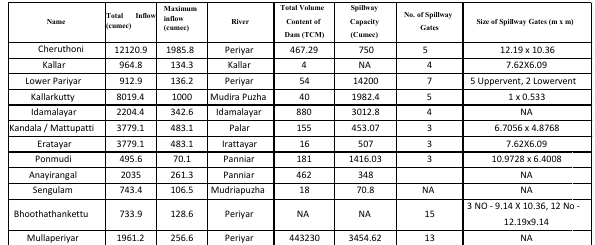
Table 3: Dams** in Periyar river basin and their characteristics